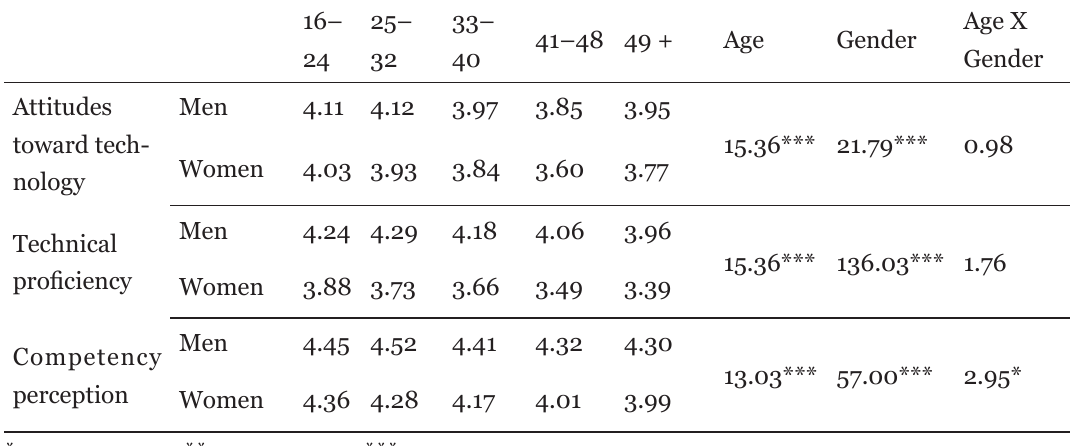
TSROL Results for Age and Gender